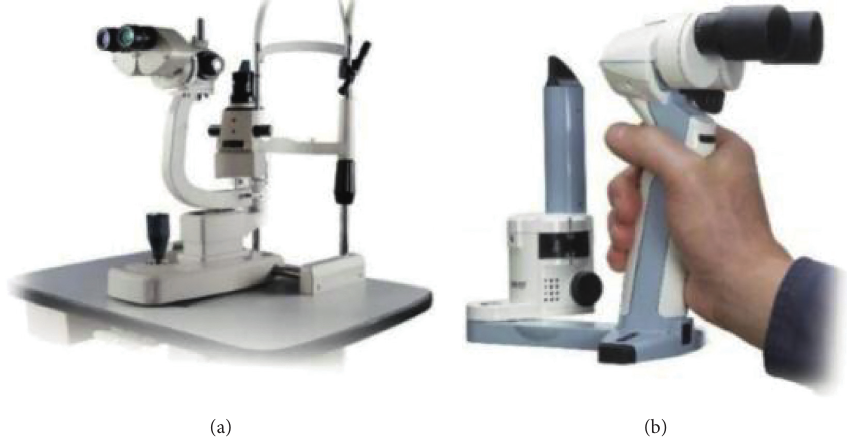
Figure 1: (a) Table-type slit-lamp. (b) Handheld